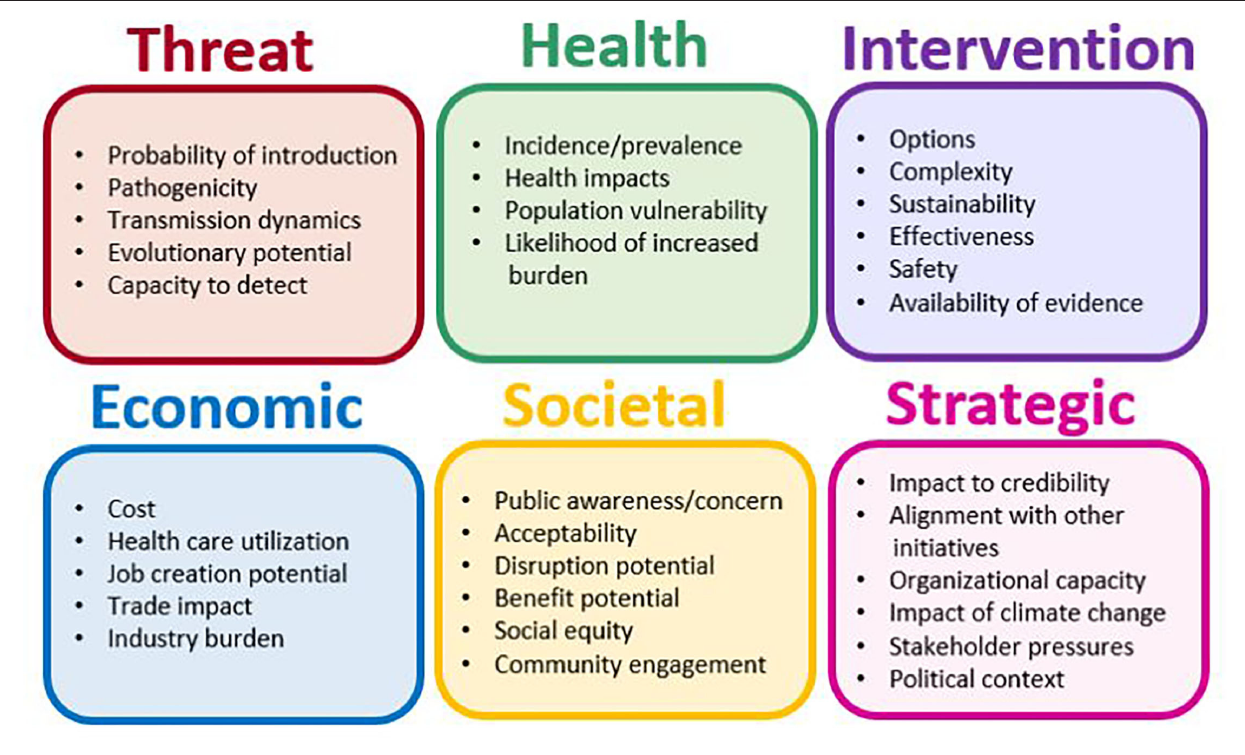
FIGURE 4 | Examples of criteria and criteria groupings within each criteria